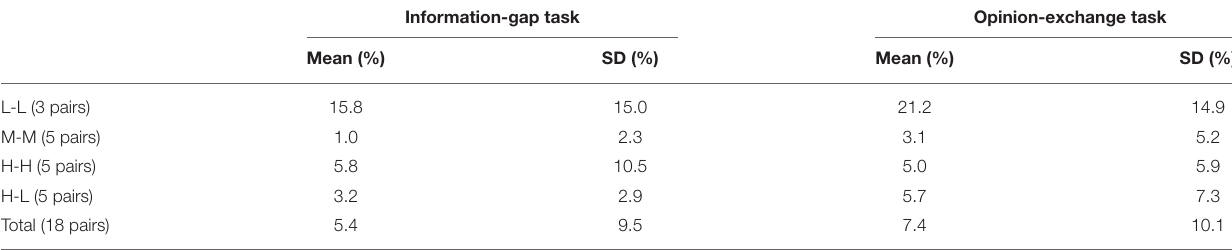
TABLE 7 | The frequency of L1 turn percentage per task type and proficiency pairing.